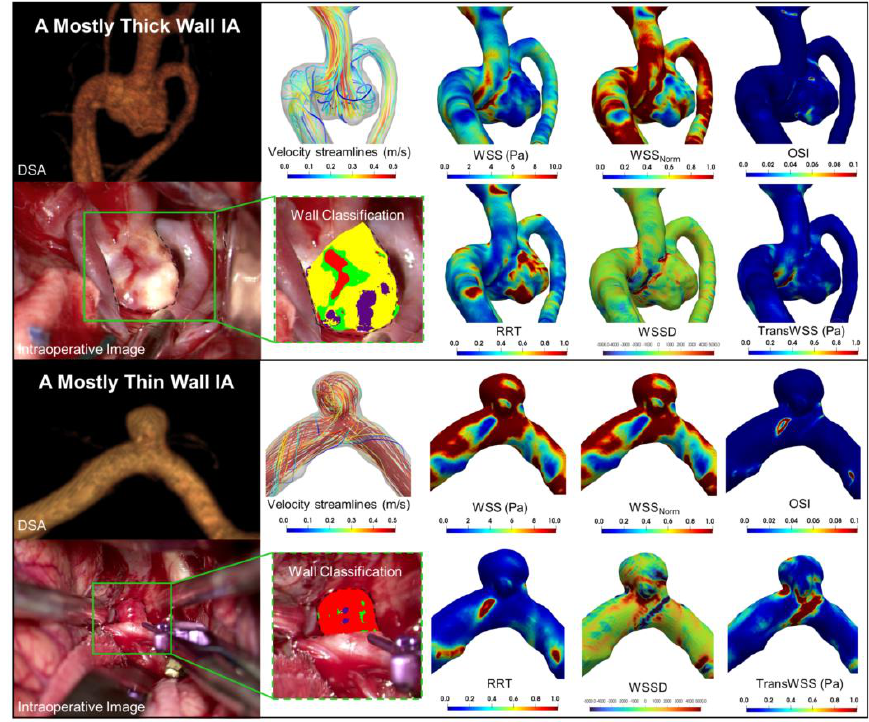
Figure 2. Visualization of cases with different wall types: Representative cases of IAs with mostly thick-walled as well as thin-walled regions, along with contours of their respective hemodynamic variables. The DSA images are displayed on the top left, and the intraoperative classification of the images are displayed on the bottom left. Thin-walled IAs had high WSS, WSS Norm , WSSD and TransWSS, and thick-walled IAs had a high RRT. Abbreviations: IA = intracranial aneurysm, DSA = digital subtraction angiography, WSS = wall shear stress, WSSNorm = normalized wall shear stress, OSI = oscillatory shear index, RRT = relative residence time, WSSD = wall shear stress divergence, TransWSS = transverse wall shear stress.